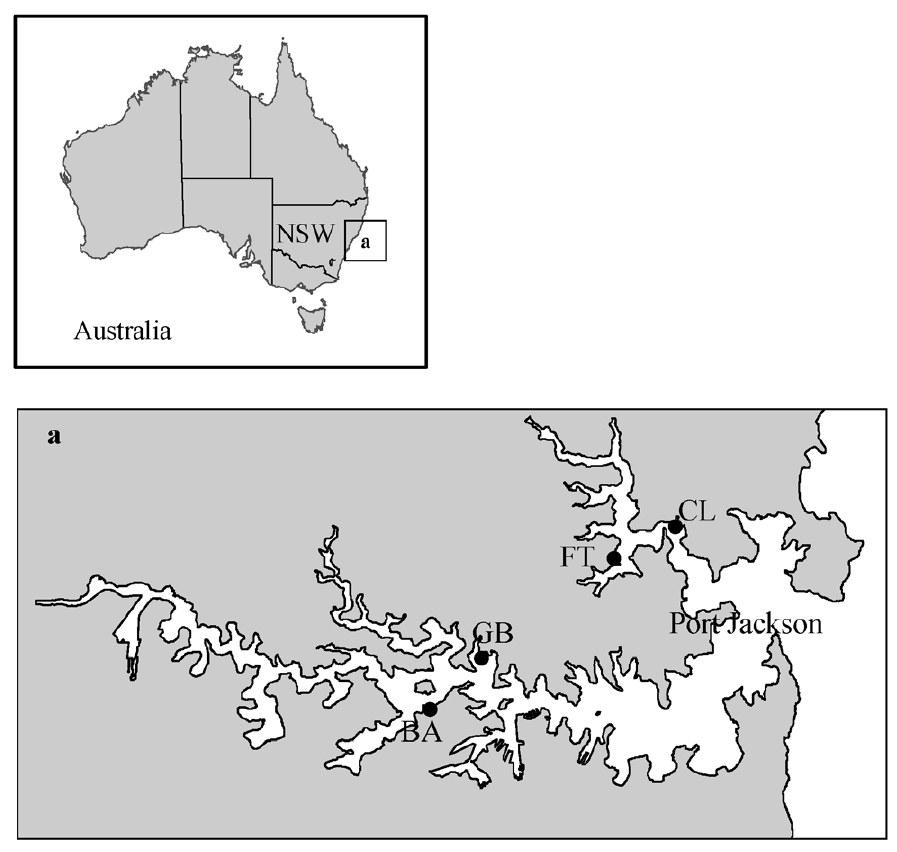
Figure 1. Study sites in Port Jackson, Australia. Sites were sampled in an in-situ underwater survey of vertical surfaces of artificial and natural habitats (BA, FT, GB and CL), photoquadrats of horizontal reef (BA, FT, GB) and sandstone plate deployment (FT). BA = Balmain, FT = Fig Tree, GB = Gore Bay and CL = Clontarf.